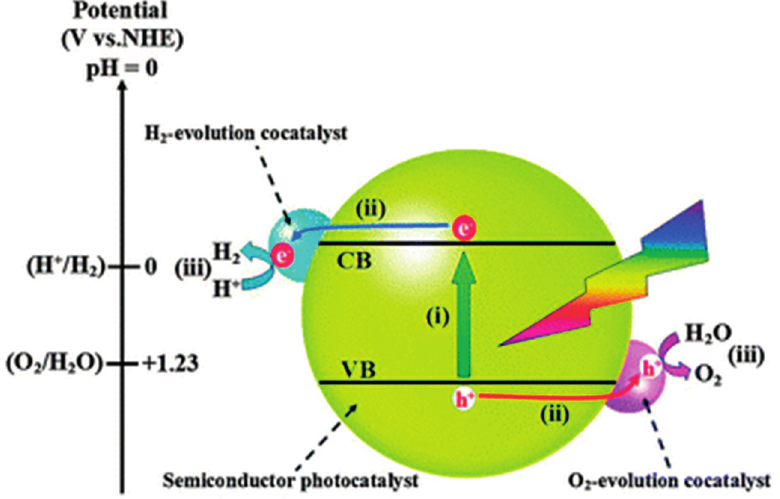
Figure 14. Photocatalytic water splitting over a visible-absorbing semiconductor loaded with H 2 - & O 2 -evolution co-catalysts (reproduced from [209] with permission of the Royal Society of Chemistry).